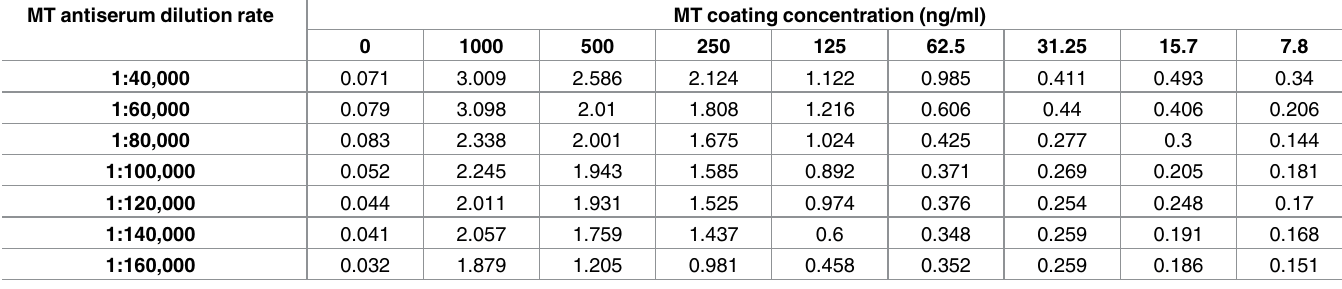
Table 3. The OD 450 of the checkerboard titration of different concentration combinations of MT anti-body and MT. MT antiserum dilution